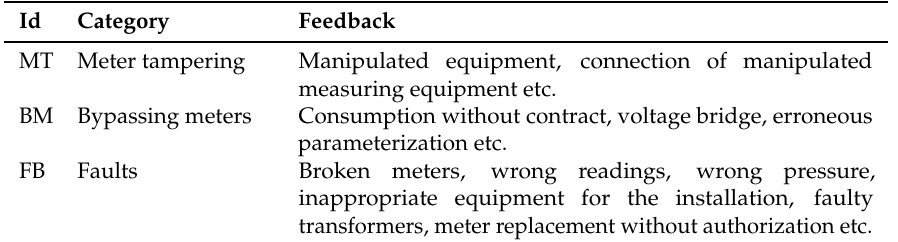
Table 1. Categorization of NTL